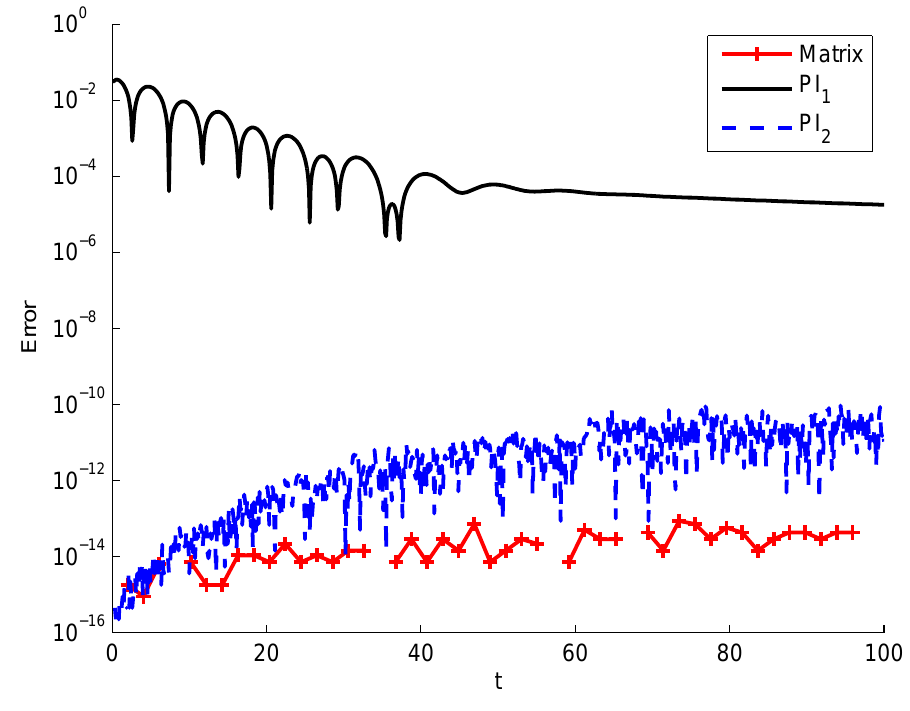
Figure 1. Error for the matrix approach and the product integration (PI) methods compared with the exact solution of the Bagley–Torvik equation. h = 2 − 3 for